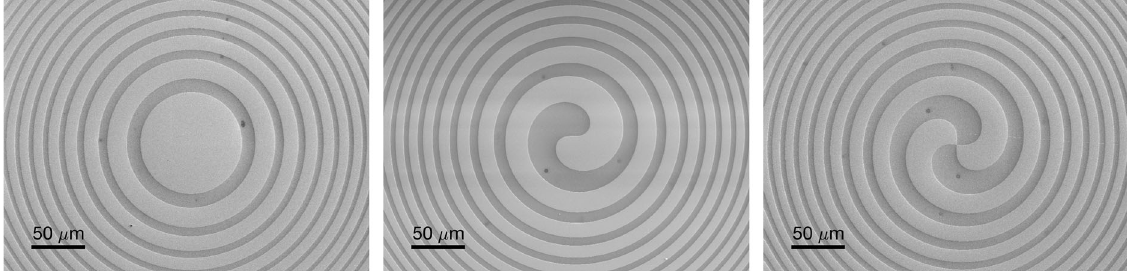
FIG. 5. SEM images of ZPs with charges of l ¼ 0 (left panel), l ¼ 1 (middle panel), and l ¼ 2 (right panel).